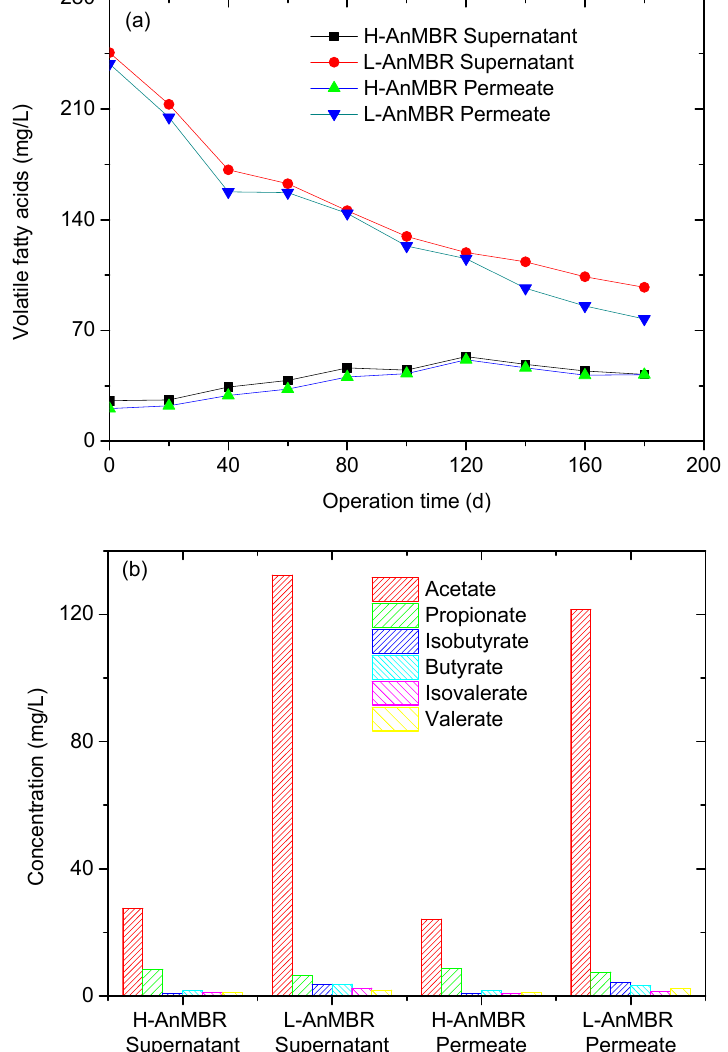
Figure 3. The change trends ( a ) and composition ( b ) of volatile fatty acids (VFAs) in the H-AnMBR and L-AnMBR.